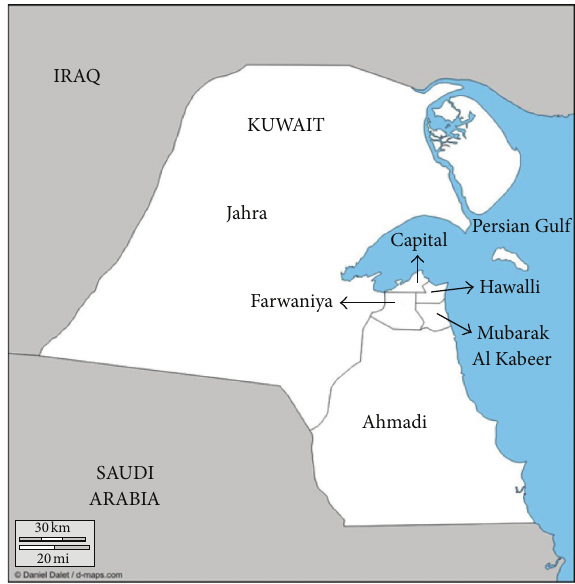
Figure 1: Map of the six governorates in Kuwait. Population by governorate in year 2012: Farwaniya (999,858), Hawalli (822,678), Ahmadi (738,023), Capital (514,198), Jahra (474,751), and Mubarak Al Kabeer (229,210). Population size represents both Kuwaiti and non-Kuwaiti nationals [11].